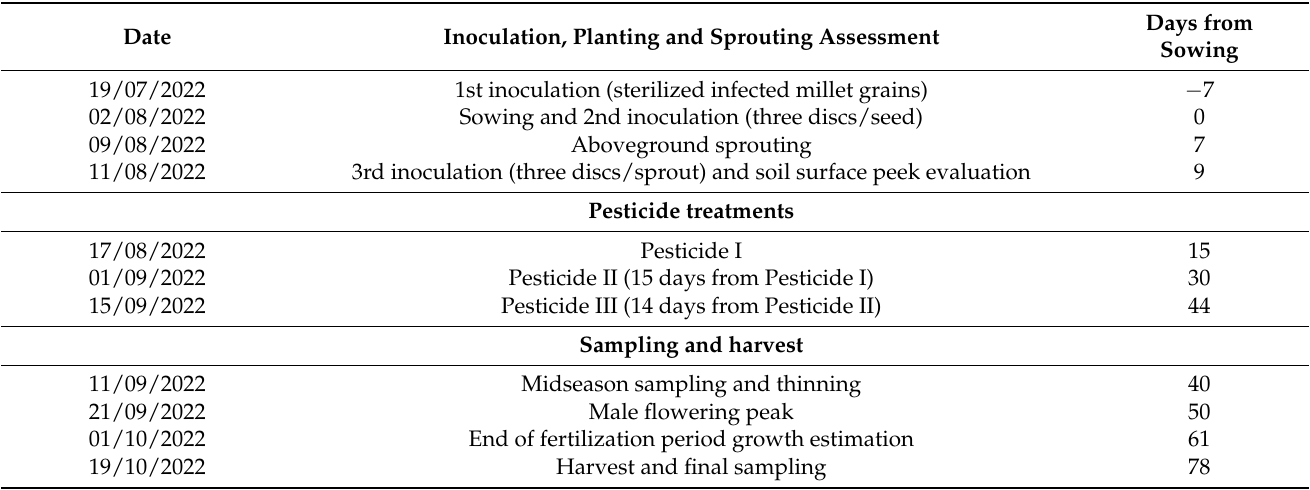
Table 2. The semi-field pot experiment’s